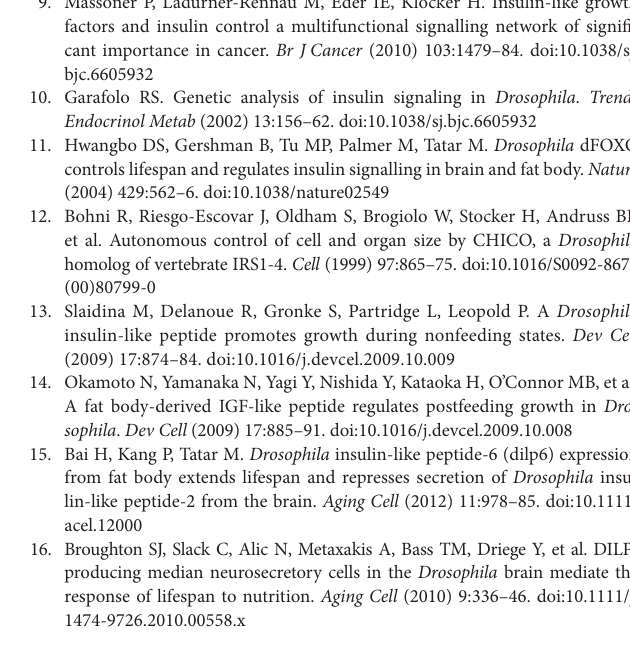
FigUre s1 | DILP2 and DILP5 induce similar gene expression by RNA-Seq. (a) Venn Diagram of differentially expressed genes by DILP2 or DILP5 stimulation. (B) PCA plot reveals separation of DILP stimulation from controls and slight separation of DILP2 from DILP5. Volcano plots reveal that DILP2 (c) and DILP5 (D) both stimulate gene expression changes with strong significance but relatively small log2 fold changes. (e) Two differentially expressed genes unique to DILP2 stimulation from RNA-Seq were verified by q-RT-PCR from separate biological samples, n = 3, * p < 0.05, ** p < 0.01. FigUre s2 | DILP2 and DILP5 stimulate changes in phosphopeptide abundance by phosphoproteomics. (a–F) Volcano plots for phosphopeptides identified in DILP2 (a–c) or DILP5 (D–F) stimulation at the indicated time point. All conditions reveal large log2 fold change values (Log2(FC)) with small significance (Log(Q value)). (g–l) Inflection points were calculated from all phosphopeptide log2 fold changes for each stimulation condition. Dotted lines represent the inflection point y-values selected as cut-offs for fold-change